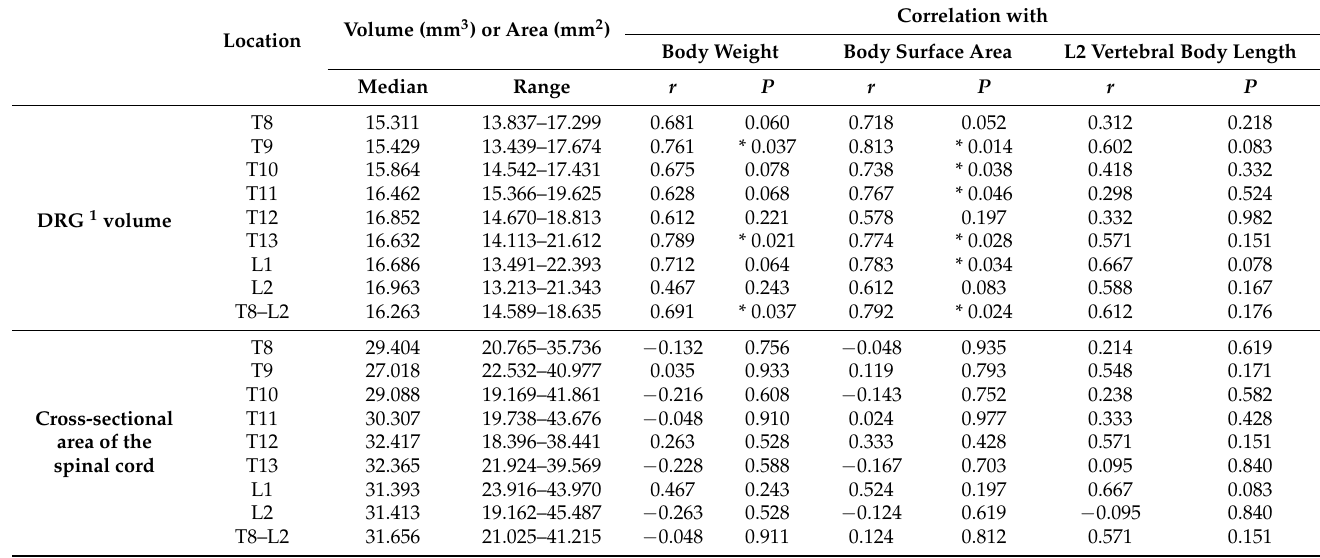
Figure A1. Depiction of dorsal root ganglion (DRG) near L1 vertebral level using conventional magnetic resonance imaging (MRI) and water-excitation MRI (Dog#12). Transverse T1-weighted image ( A ), T2-weighted image ( B ), and fluid-attenuated inversion recovery image ( C ) could not depict DRG. On the other hand, water-excitation image ( D ) could depict DRG clearly (white arrows). Table A1. Correlation between DRG volume or cross-sectional area of the spinal cord and body weight, body surface area, or L2 vertebral body length in control